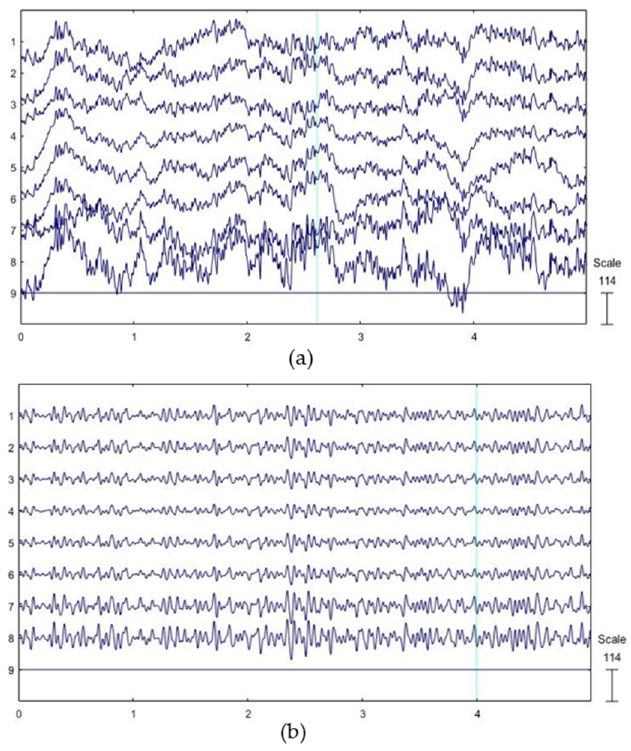
Figure 4. Comparison of 8-channels 4 s EEG signal before and after filtering. ( a ) is the EEG signal before filtering and ( b ) is the EEG signal after filtering.